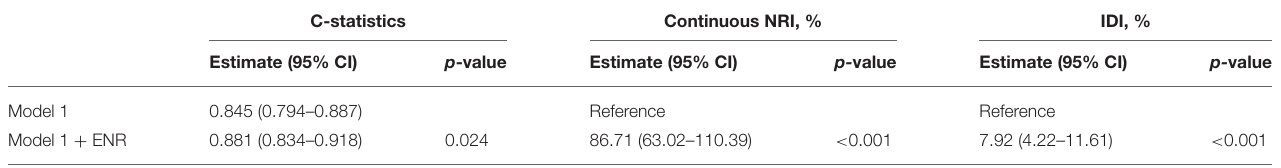
TABLE 5 | C-statistics and reclassification analyses for ENR to improve the risk stratification of poor 3-month outcome.